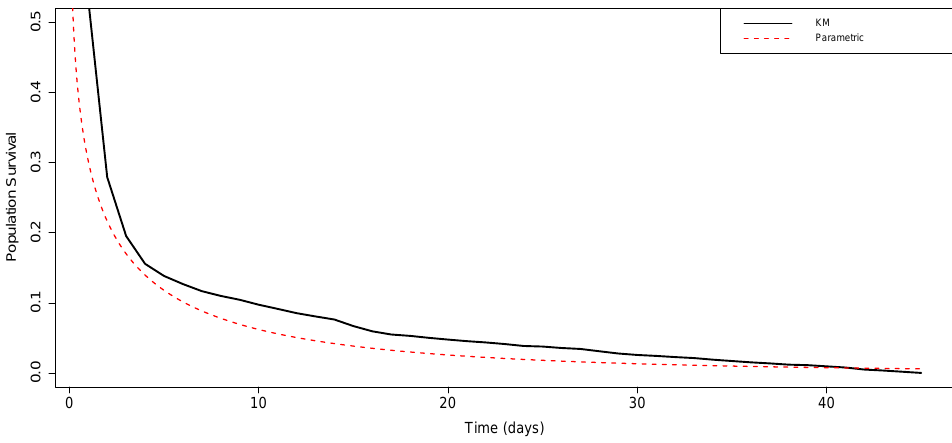
Figure 7. Average KM estimator and population